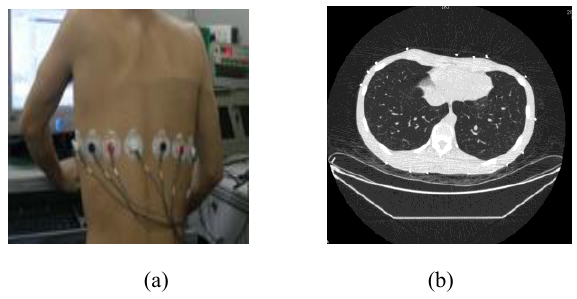
Fig.4 . Experiments tested in a man lung. (a) Data acquisition electrodes. (b) Reconstructed XCT